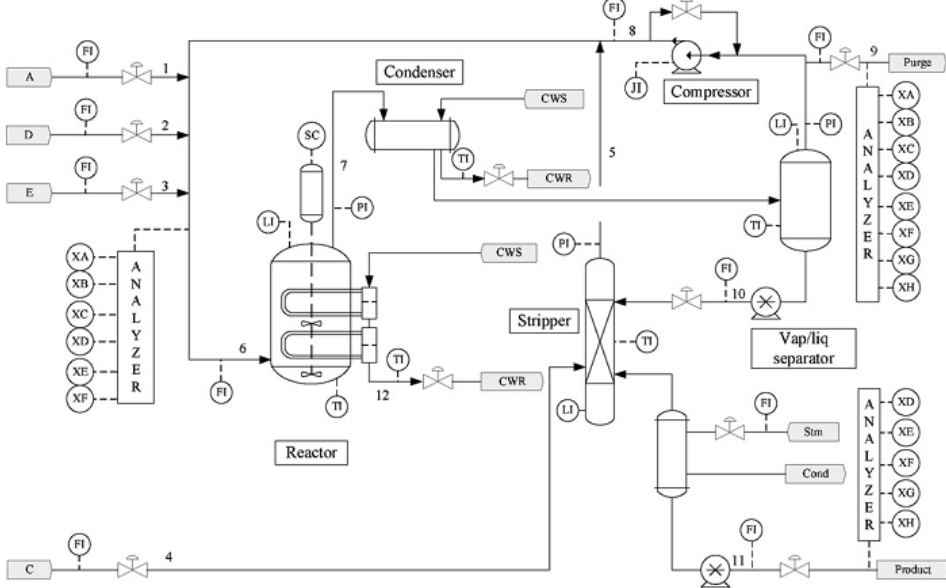
Figure 4. Flow sheet of the Tennessee Eastman process. Table 4. Manipulated variables in the Tennessee Eastman process.